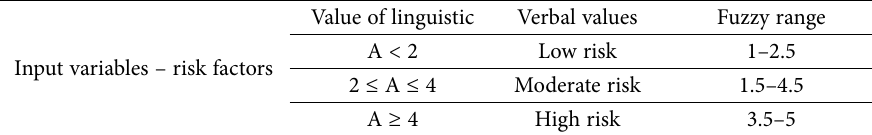
Fuzzy rangeVerbal valuesValue of linguistic